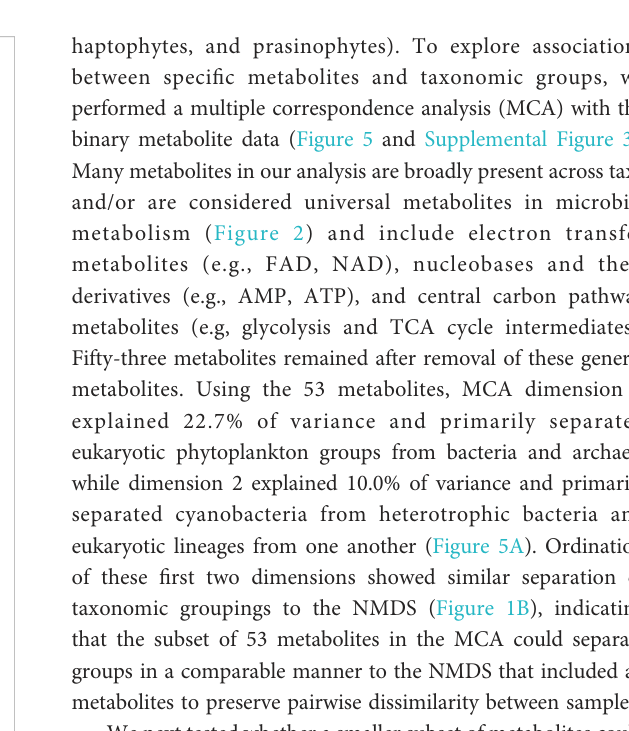
FIGURE 3 Thirteen metabolites exclusive to cyanobacterial and eukaryotic phytoplankton and absent in heterotrophic bacteria or archaea. Dashed blue lines: nitrogen-containing metabolites; Dashed yellow lines: sulfur-containing metabolites. Hydroxyectoine was also speci fi c to phytoplankton in our analysis, but it was not included in the fi gure as there is evidence that it is conditionally produced in archaea and bacteria under high osmolarity conditions (Czech et al., 2018). DHPS, 2,3-dihydroxypropane-1- sulfonate; DMSAc,